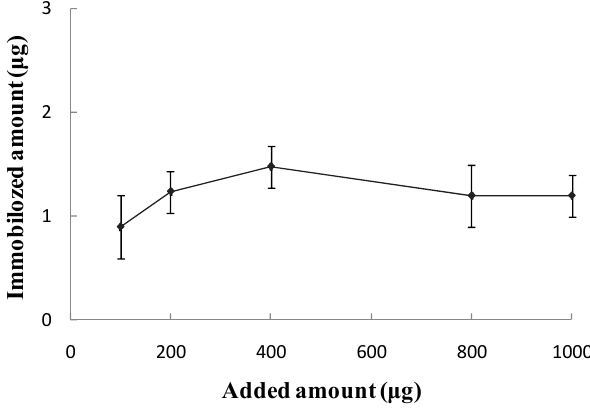
Figure 6. Immobilization ability of polyclonal antibody on 1 mg of gold-magnetic nanoparticles.